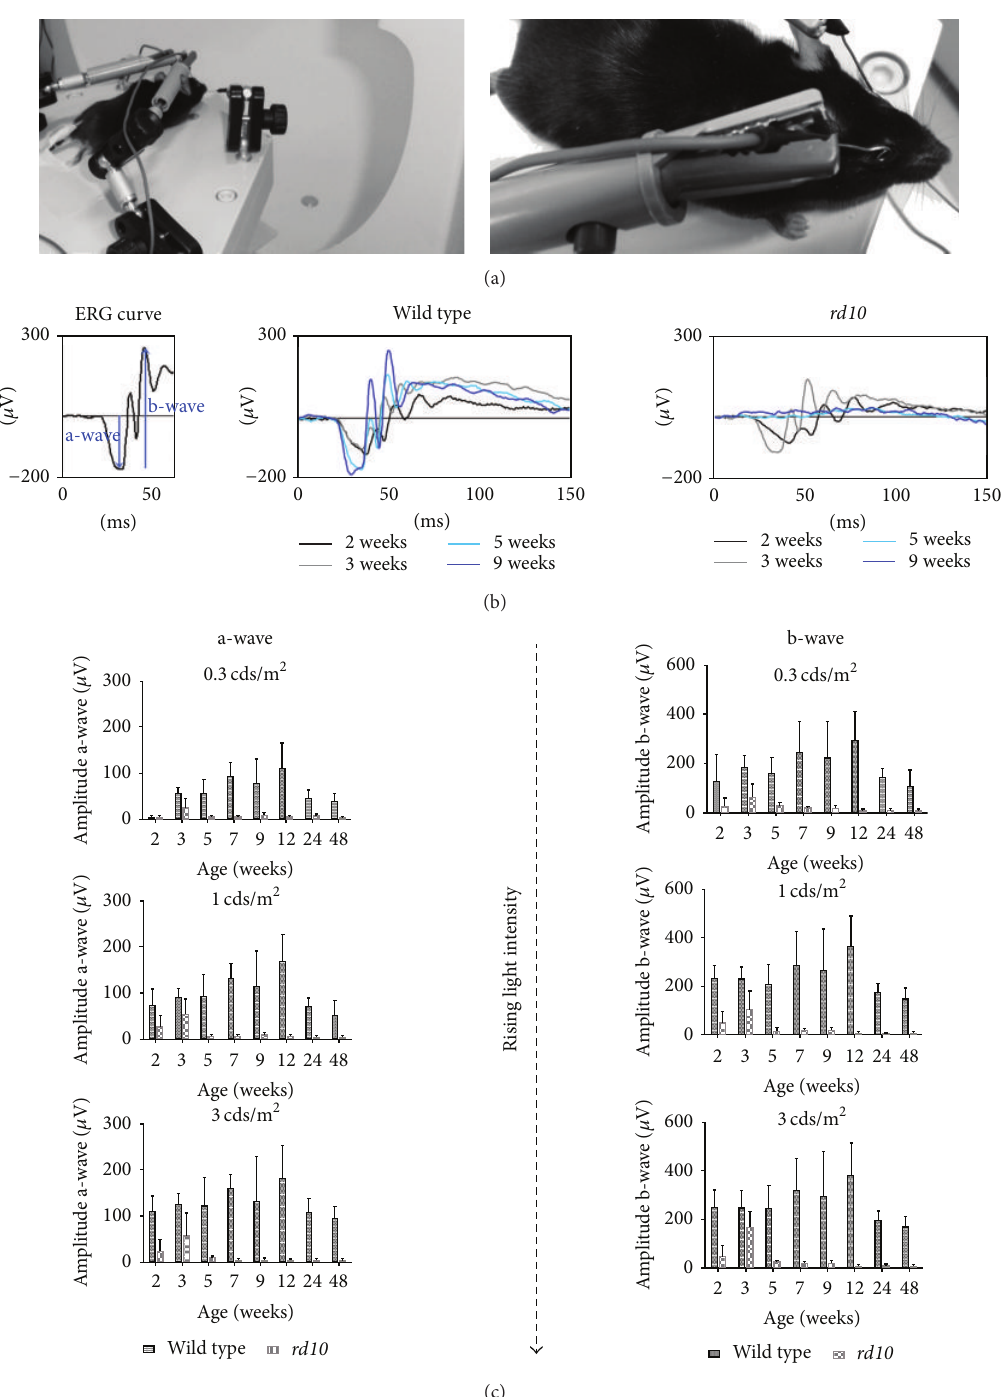
Figure 1: Electroretinogram recordings in wild type and rd10 mice. (a) Left: mice were fixed in front of a Ganzfeld stimulator in a standardized position. Right: goldring electrodes were used on both eyes as active electrodes. A goldring electrode in the mouth served as reference and a subcutaneous needle electrode in the lumbar region as ground electrode. (b) The first graph serves as example for an ERG recording with designated a-wave and b-wave. In the following examples, ERGs of the left eye of wild type (second graph) and rd10 mice (third graph) at different ages (2, 3, 5, and 9 weeks) are illustrated. While in wild type mice, the amplitudes of a- and b-waves increased with age up to 12 weeks, in rd10 mice, an ERG was only recordable until the age of 3 weeks. (c) Amplitudes of the ERG’s a-wave (left panel) and b-wave (right panel) in wild type mice (black bars) and rd10 mice (grey bars) are plotted against the stimulus intensity (first row: 0.3 cds/m 2 , second row: 1cds/m 2 and third row: 3 cds/m 2 ) and to age given on the abscissa. Vertical bars indicate the mean values ± standard deviation ( 𝑛 = 3 per age